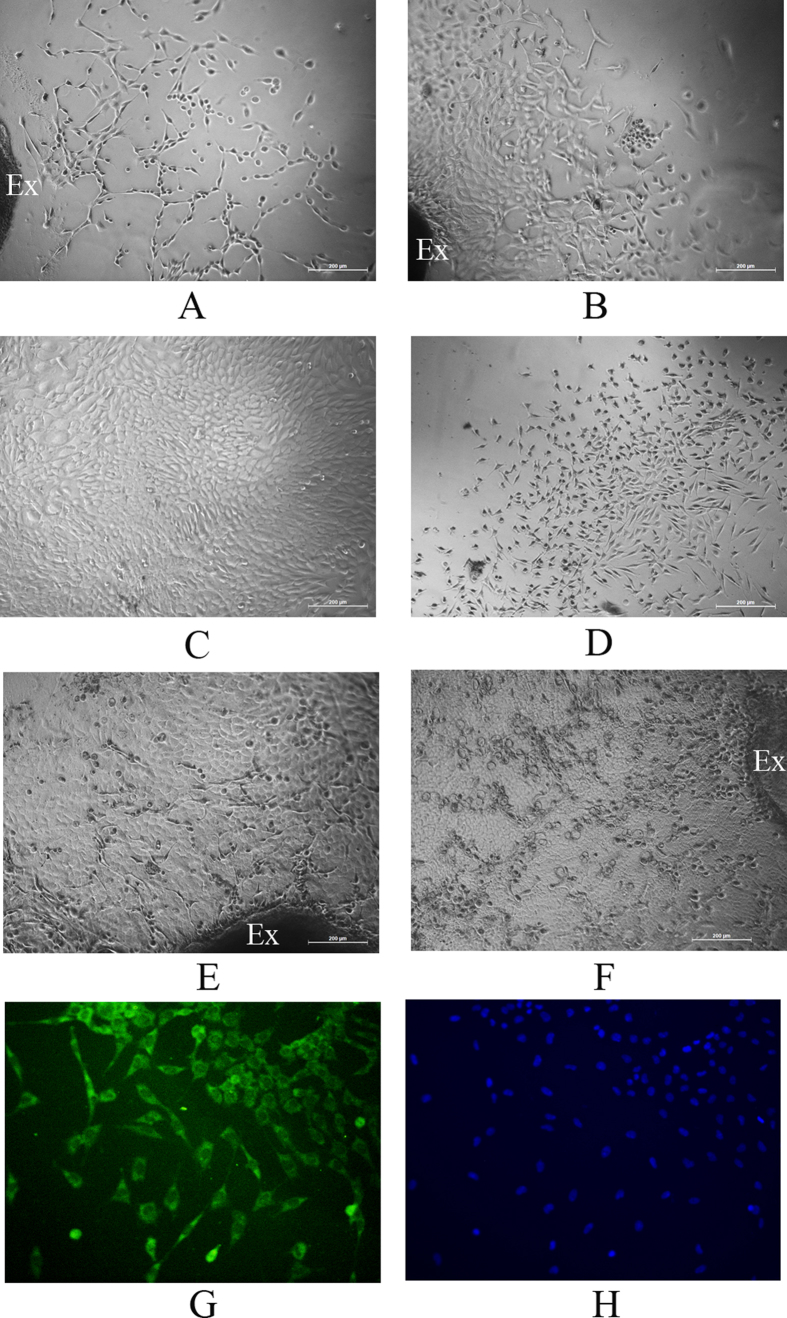
Effect of Am films on growth of keratocytes.Corneal explants (marked as Ex) were cultured on Am films, sprouting of keratocytes from the implant were observed on day 4 (A), the cellular growth increased on day 6 (B) and generated a cell sheet on day 10 with flattened dendritic shaped keratocytes (C). Keratocytes grown on culture discs (D). Am films also supported growth of epithelial cells over the existing keratocyte cell layer (E,F). Keratocytes expressed vimentin (G), nuclei stained with DAPI (H).